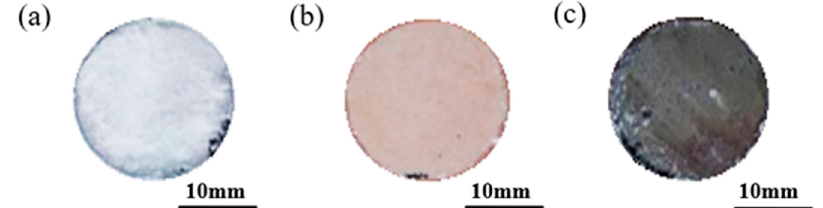
Figure 5. Macrograph of three MAO coatings, ( a ) MAO, ( b ) MAO–Cu 2 CO 3 (OH) 2 · H 2 O and ( c ) MAO–